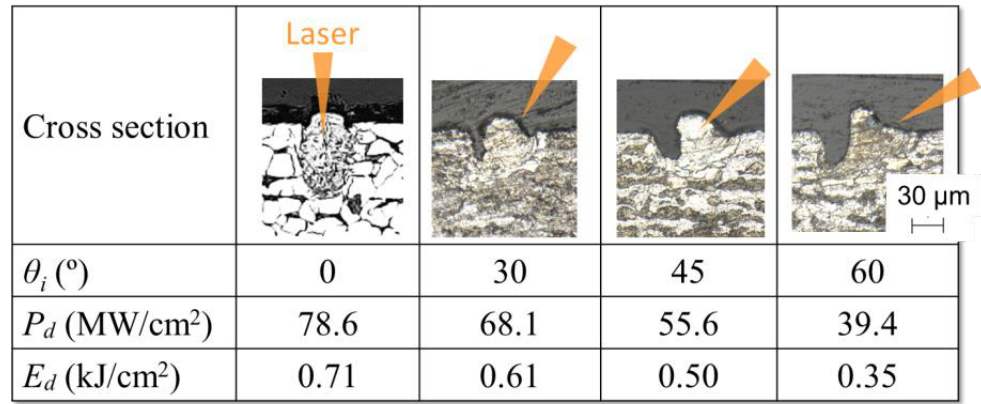
Figure 3. Cross sections of micro-grooves obtained at various incident angles (Power ( P ) = 200 W, scanning speed ( V s ) = 2 m/s, and diameter in the processing direction (d s ) = 18 μm, mild steel).